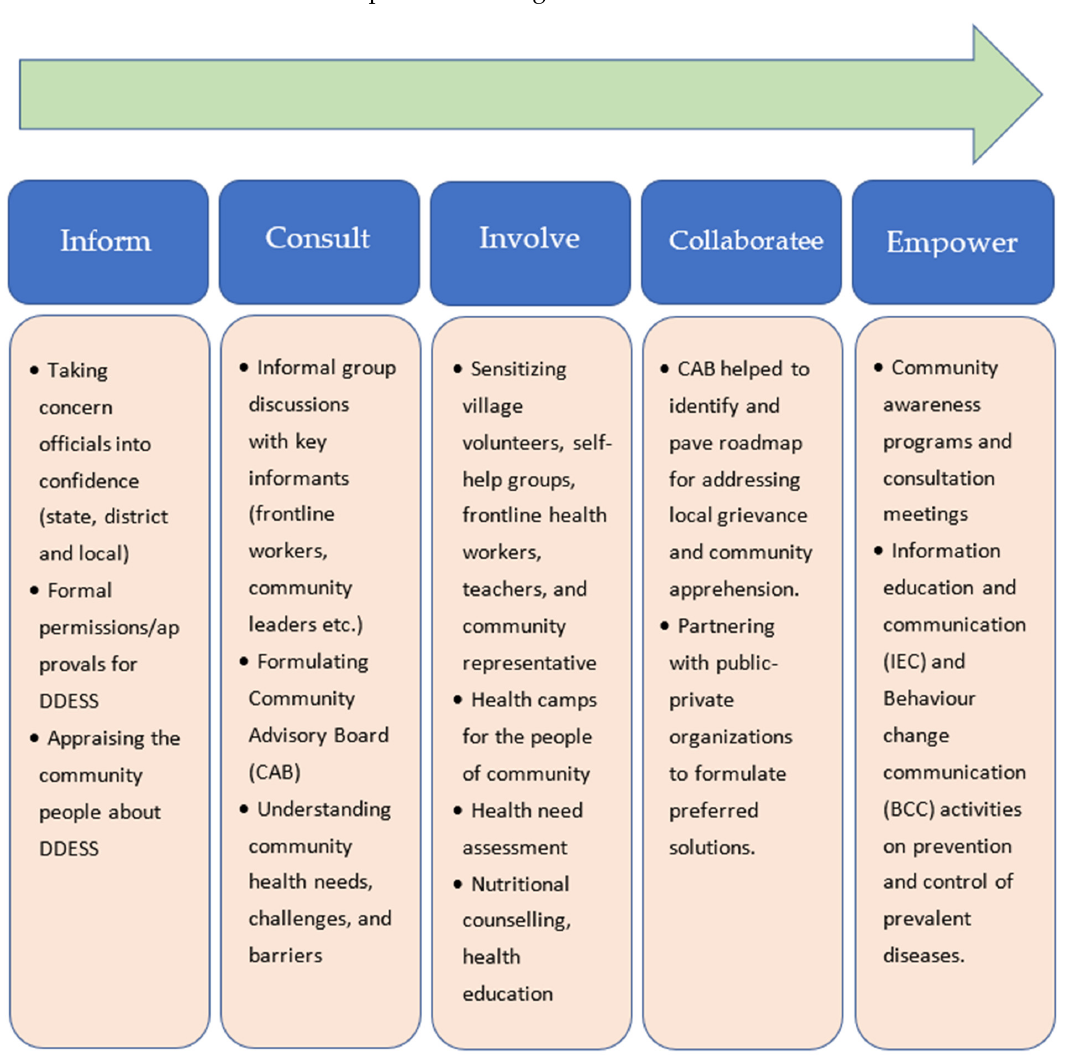
Figure 2. Process adopted for community engagement.